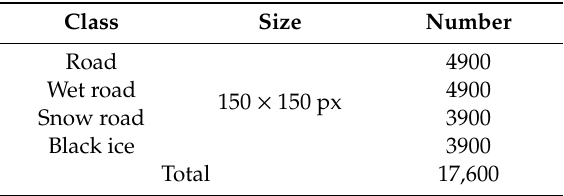
Table 5. Number of data through 1st preprocessing.